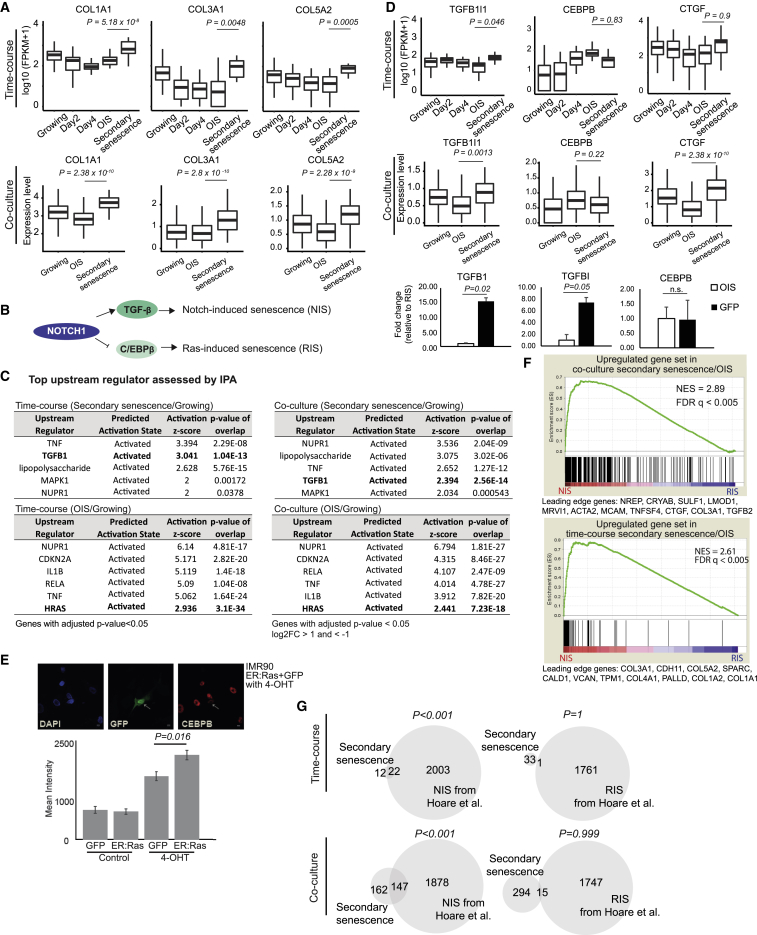
Secondary Senescence Comprises NIS Signature in the Majority of Cells(A) Boxplots for the expression of genes COL1A1, COL3A1, and COL5A2 in the time course and co-culture experiments (p < 0.05). The top and bottom bounds of the boxplots correspond to the 75th and 25th percentile, respectively. p values were obtained using differential analysis in SCDE.(B) Model suggesting NIS and RIS are regulated by Notch1 through TGFB and CEBPB, respectively.(C) IPA analysis of the two senescence clusters from the time course and co-culture experiments relative to growing.(D) Boxplots for the expression of TGFB1I1, CTGF, and CEBPB genes in the time course (top) and co-culture experiments (middle). The top and bottom bounds of the boxplot correspond to the 75th and 25th percentile, respectively. p values were obtained using differential analysis in SCDE. Bar graphs denoting expression of TGFB1 (n = 6), TGFBL (n = 6), and CEBPB (n = 3) mRNA as measured by qPCR in OIS and GFP cells (bottom) (TGFB1: t = −3.2317, df = 5.5117, p = 0.02; TGFBI: t = −2.2567, df = 9.8141, p = 0.05; CEBPB: t = 0.068192, df = 3.2294, p = 0.95, unpaired Student’s t test. Error bars represent SEM).(E) Representative image of GFP (secondary senescence) and CEBPB (red) immunofluorescence in the co-culture experiment. Mean intensity for primary (ER:Ras) and secondary senescent cells (GFP) was measured (p = 0.016, unpaired Student’s t test). Error bars are displayed as SEM.(F) GSEA plots for the enrichment of secondary and primary OIS DE genes (time course and co-culture experiments) in Hoare et al. (2016) NIS and RIS log2FC preranked genes. Normalized enrichment score (NES) and false discovery rate (FDR) are shown.(G) Venn diagrams overlapping expression signatures from time course (top) and co-culture (bottom) with NIS signature genes. (Secondary senescence: Secondary senescence/OIS upregulated genes; NIS: Hoare et al. (2016) NIS/RIS upregulated genes; RIS: Hoare et al. (2016) RIS/NIS upregulated genes.)Related to Figure S2 and Table S4.